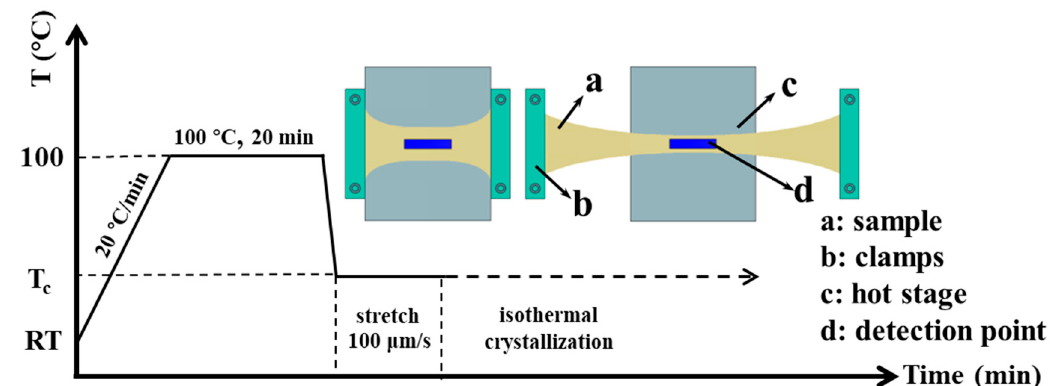
Figure 1. Schematic illustration of the experimental procedure.